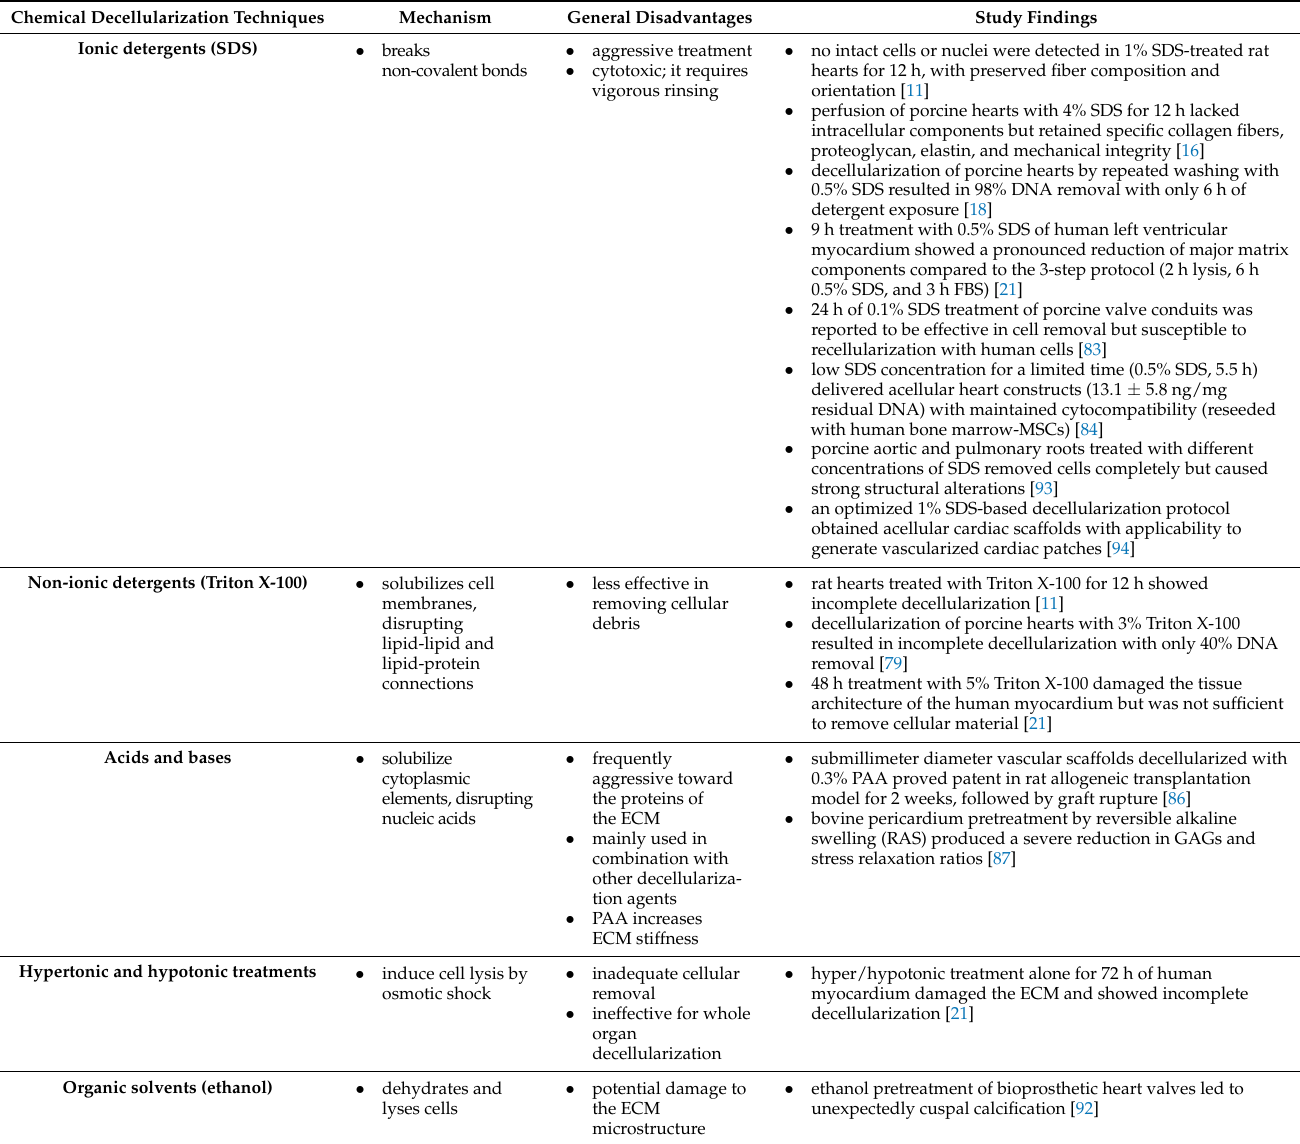
Table 2. Different chemical methods used for cardiac tissue